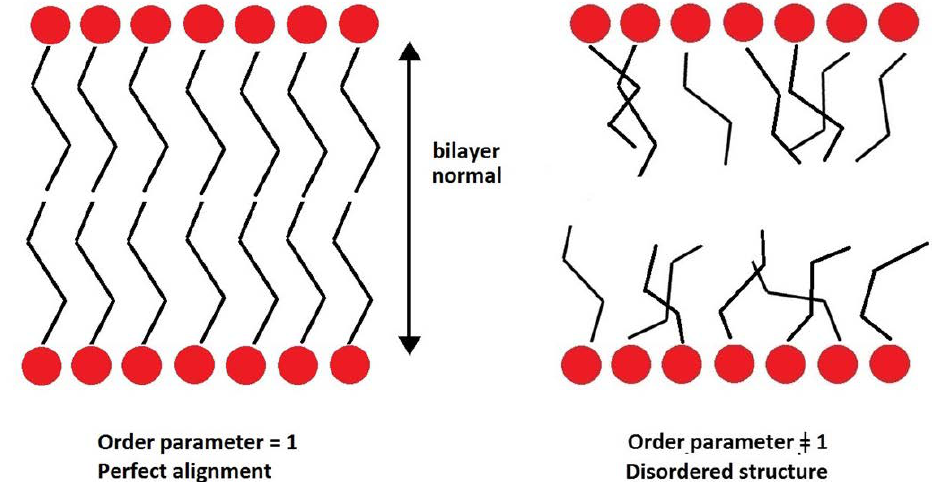
Figure 3. Relationship between P 2 and degree of order of a lipid bilayer.